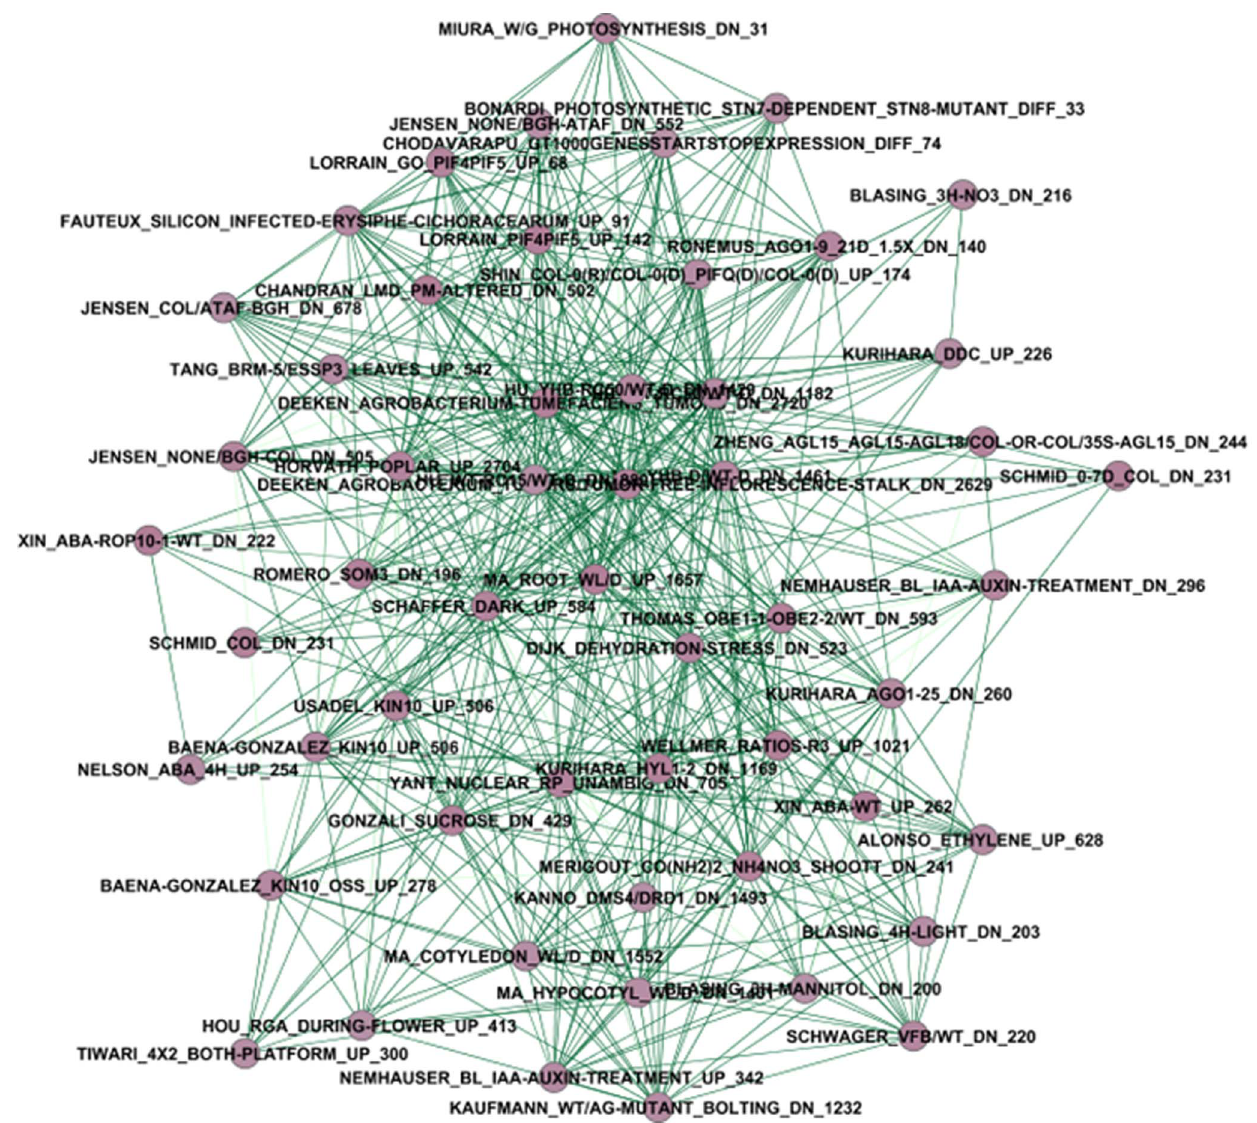
Figure 4. Sub-network 2 corresponding to the module 2/cluster 2 (see note in Figure 2 for meanings of node and edge and their